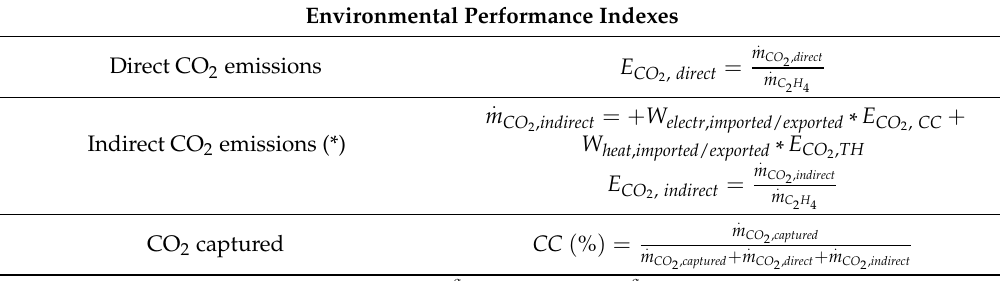
Table 3. Definition of the indexes used for the evaluation of the environmental performance of the